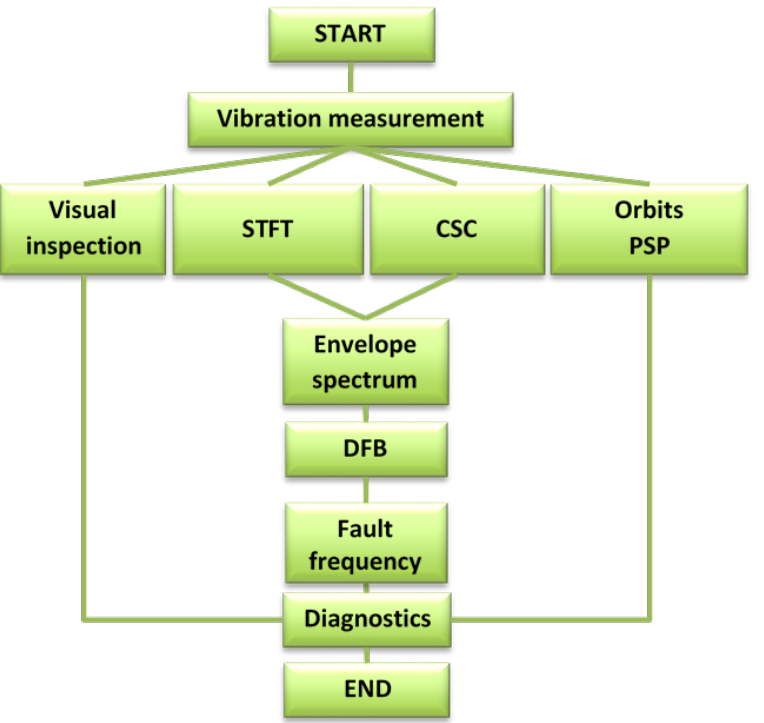
Figure 1. The scheme of diagnostics methodology: STFT—short FFT; CSC—cyclic spectral coherence; PSP—phase space plot; DFB—diagnostic frequency